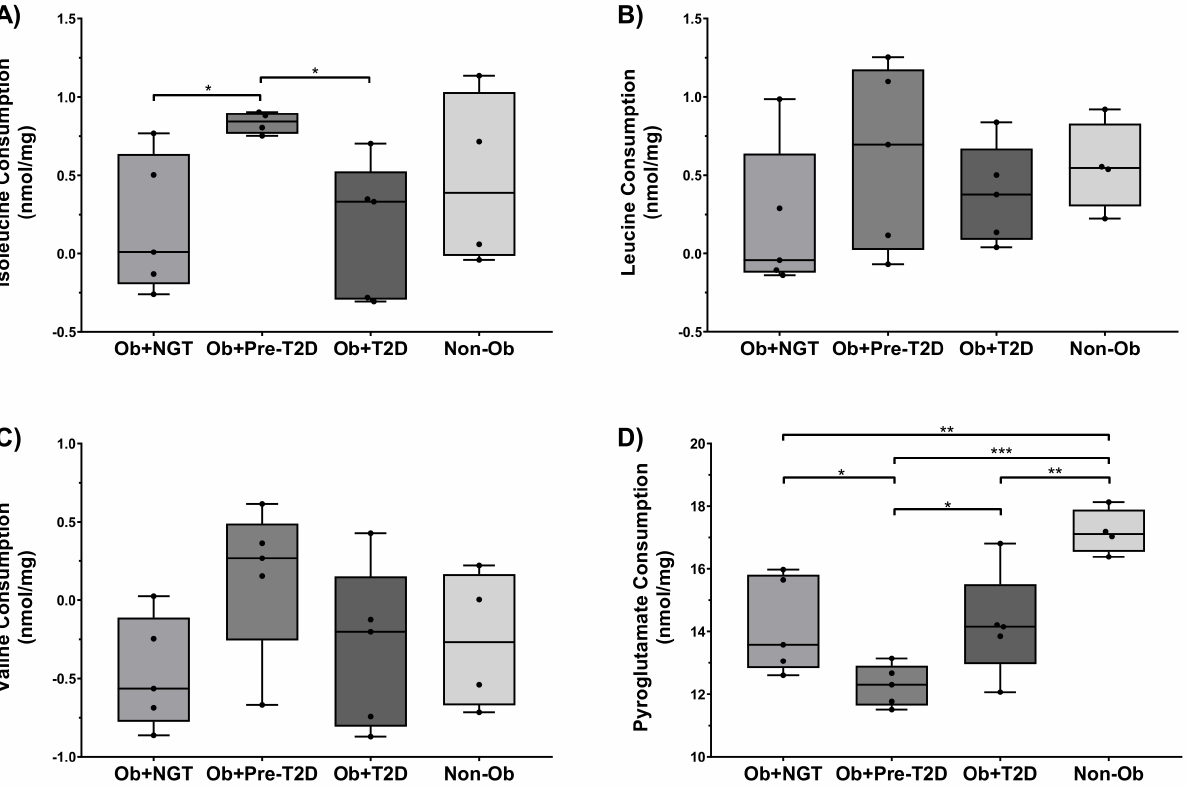
Figure 2. Isoleucine ( A ), leucine ( B ), valine ( C ) and pyroglutamate ( D ) consumption by visceral adipose tissue (VAT) explants. Subjects were grouped according to body mass index (BMI) and glycemic status (with obesity and euglycemia- Ob+NGT; with obesity and pre-diabetes-Ob+Pre-T2D; with obesity and T2D-Ob+T2D; without obesity-Non-Ob). Data are presented as boxplots with quartiles and all points plotted. * p < 0.05; ** p < 0.01; *** p <